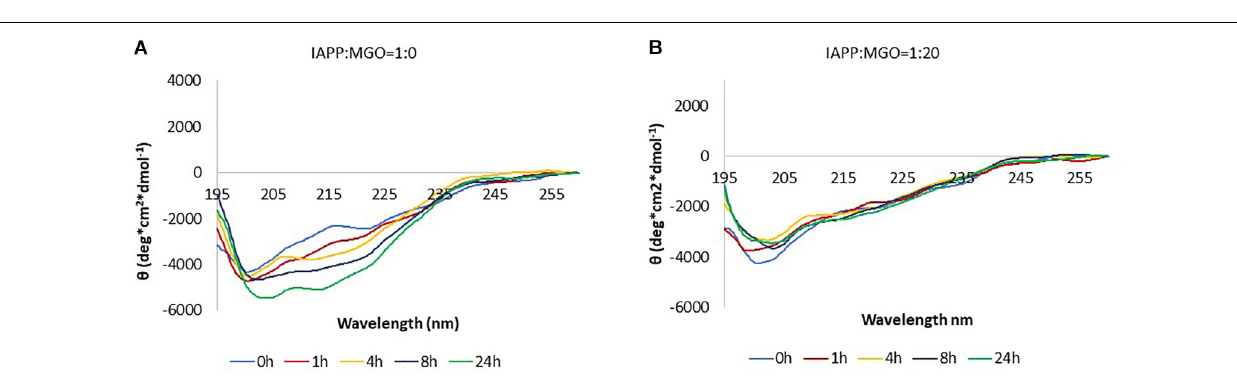
FIGURE 5 | Kinetics of aggregation of IAPP followed by CD. The data were collected in the absence (A) and in the presence (B) of MGO. The data were acquired at 37 ◦ C, on 20 µ M peptide and with a 20-fold molar excess of MGO. No shaking was applied in between measurements. TABLE 1 | Secondary structure content estimated from deconvolution of the CD data. IAPP IAPP +